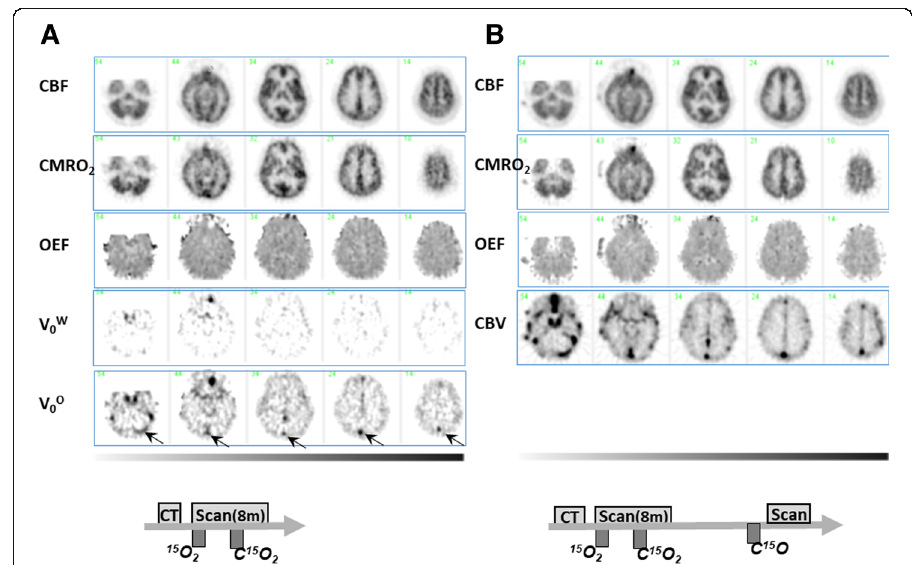
Fig. 9 Example functional images of CBF, CMRO 2 , OEF, and vascular volume images of the arterial blood volume for H 15 O ( V 0W ) and that for 15 O 2 ( V 0O ), and CBV, obtained from a healthy volunteer of a 22-year-old male of the body weight 68 kg, with the net administration dose 503, 267, and 592 MBq corresponding to C 15 O, 15 O 2 , and C 15 O 2 inhalation, respectively. Functional images were calculated according to a modified DBFM [26] ( a ) and a DARG [25] ( b ) methods. Note that the functional images on both A and B were calculated from the same data acquired with the single PET scan during sequential inhalation of 15 O 2 and C 15 O 2 , but without C 15 O scan data on ( a ) . CBV indicates high counts in the sinus area, while V 0W does not show. V 0O demonstrates significantly high counts. Of note is that image quality was reasonably well